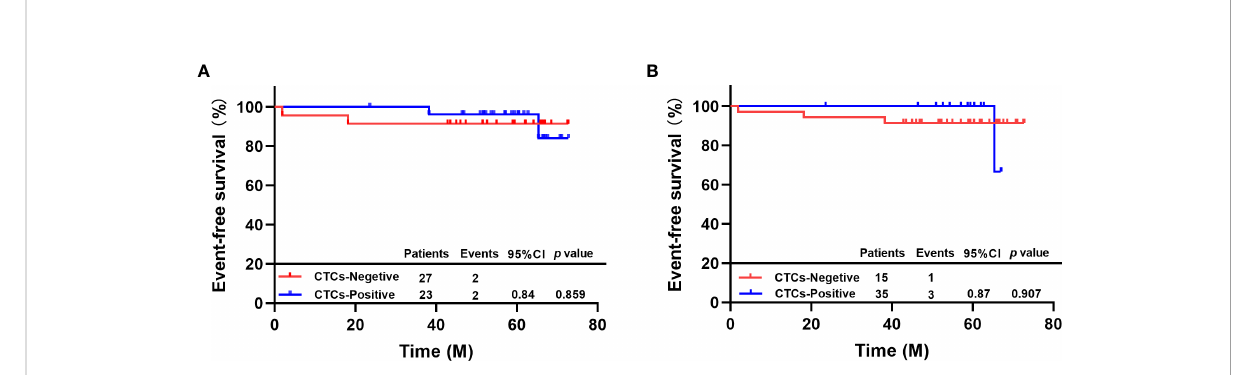
FIGURE 2 (A) EFS of patients with different CTC status by TUMORFISHER method; (B) EFS of patients with different CTC statuses by CellSearch. .